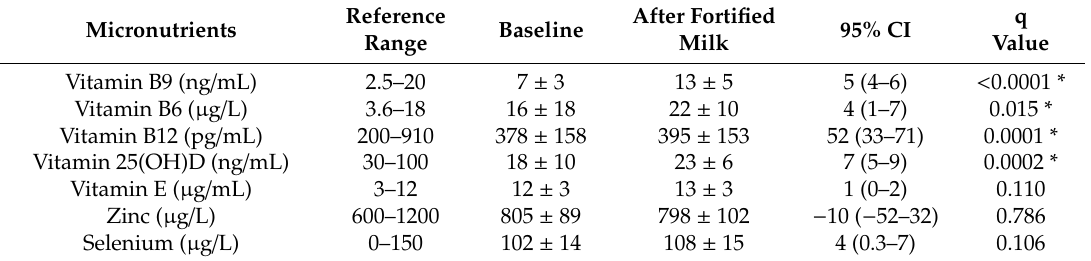
Table 5. Measurement of circulating micronutrient levels at baseline and after treatment in all